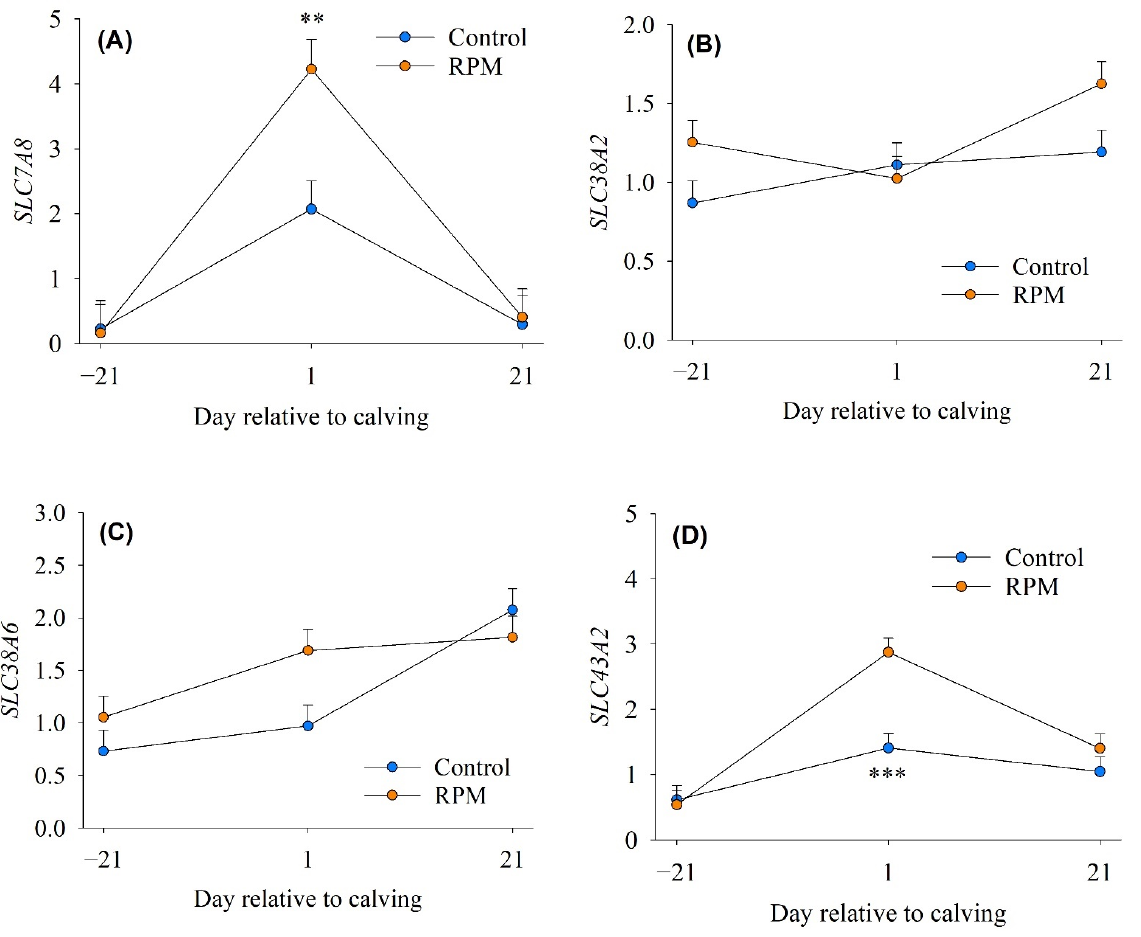
Figure 1. mRNA abundance of genes associated with amino acid transport in skeletal muscle of dairy cows ( n = 10/diet) fed a basal control diet or the basal diet plus ethyl-cellulose rumen-protected methionine (RPM) from − 21 to 21 day of calving. ( Panel A ), solute carrier family 7 member 8 ( SLC7A8 ); ( Panel B ), solute carrier family 38 member 2 ( SLC38A2 ); ( Panel C ), solute carrier family 38 member 6 ( SLC38A6 ); ( Panel D ), solute carrier family 43 member 2 ( SLC43A2 ). Error bars represent SEM. ** p < 0.01, *** p < 0.001. Table 2. mRNA expression of genes in skeletal muscle of dairy cows ( n = 10/diet) fed a basal control diet or the basal diet plus ethyl-cellulose rumen-protected methionine (0.9 g/kg DMI at prepartum